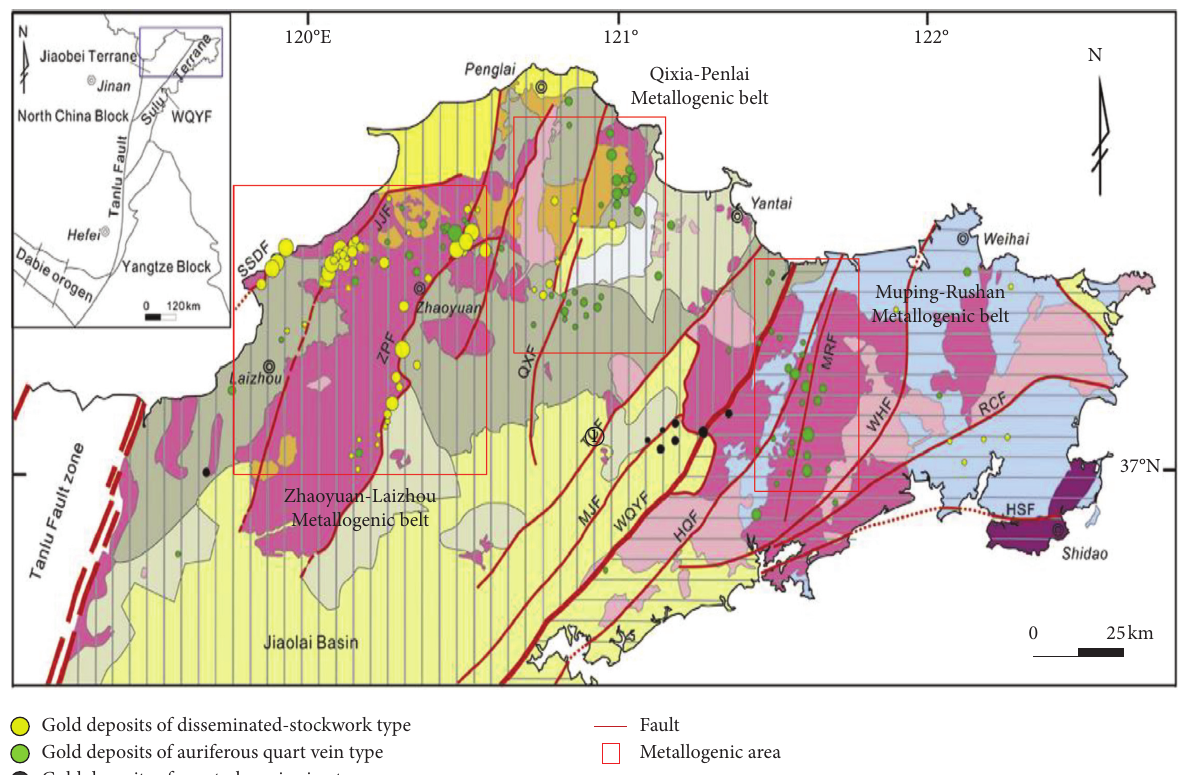
Figure 2: Distribution of faults and metallogenic belts in Jiaodong, China